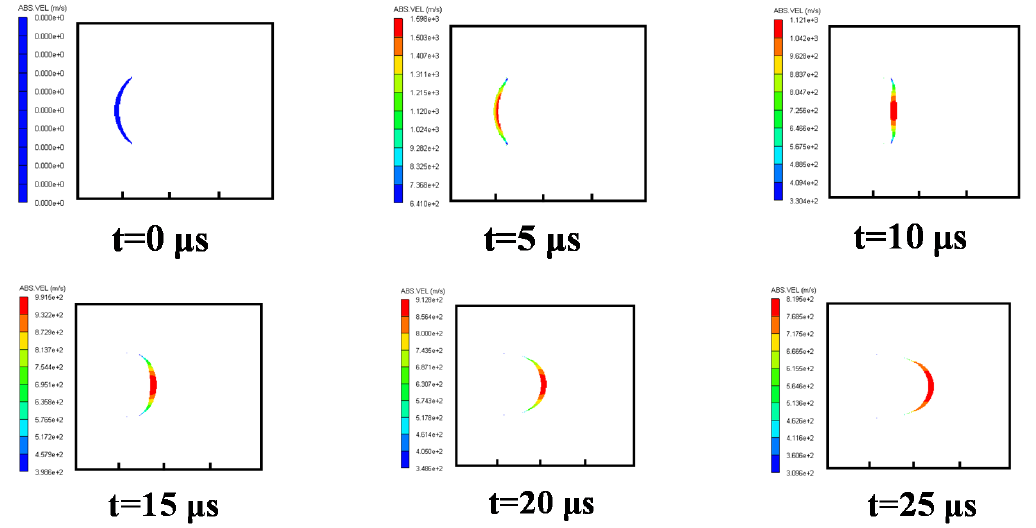
Figure 8. Velocity distribution of the EFP in a formation process in water.